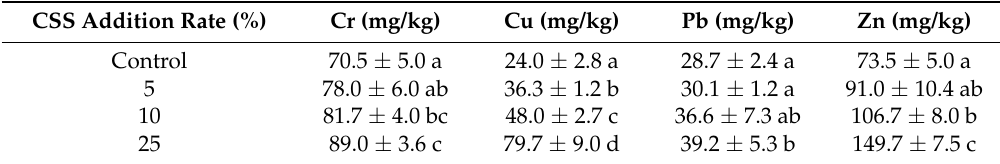
Table 2. Total heavy metal concentrations in the control and amended soil.